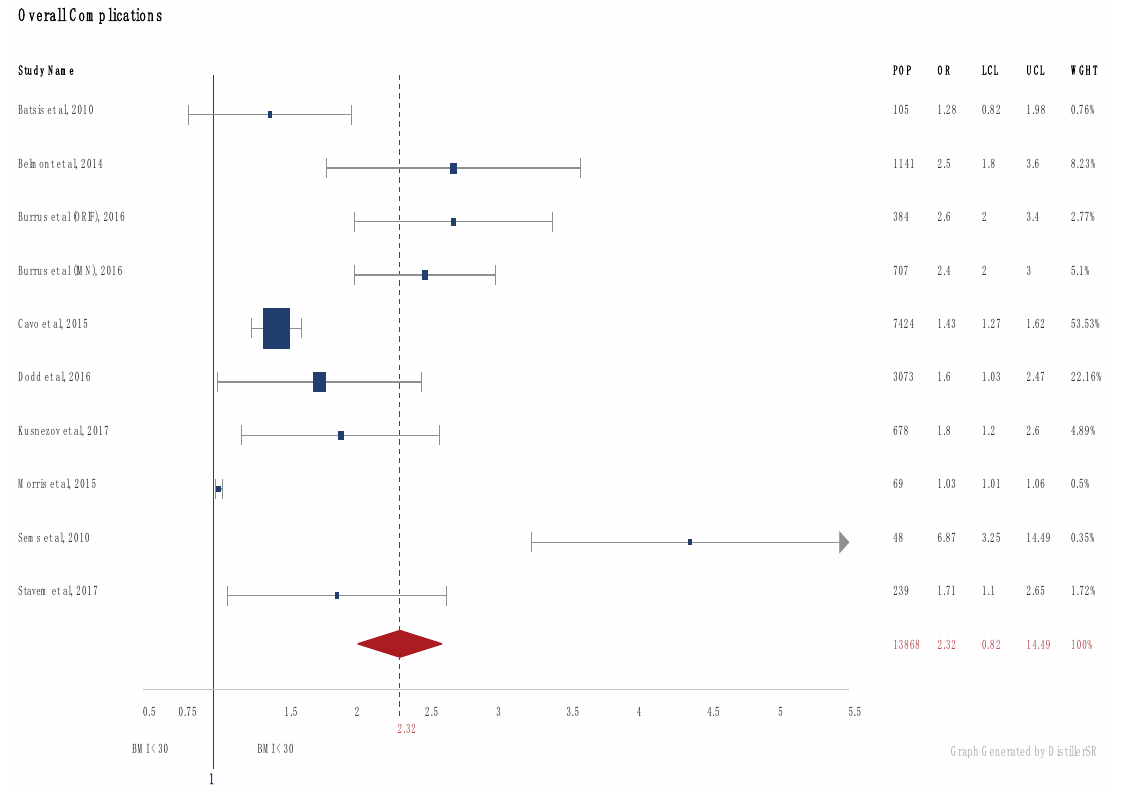
Figure 2. Forrest plot of overall complications in patients > 30 Body Mass Index (BMI). (Number of patients (POP), Odds Ratio (OR), Upper (UCL) and Lower (LCL) Confidence interval and Weight (WGHT). Square reflects the number of patients and the diamond represents the total effect.